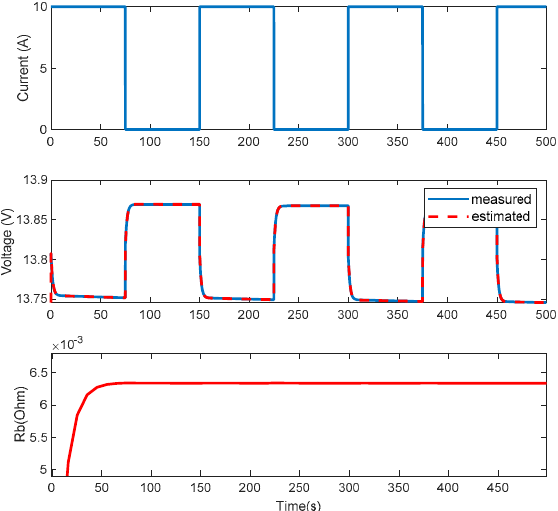
Figure 4. Battery internal resistance identification under constant pulse current (simulation).